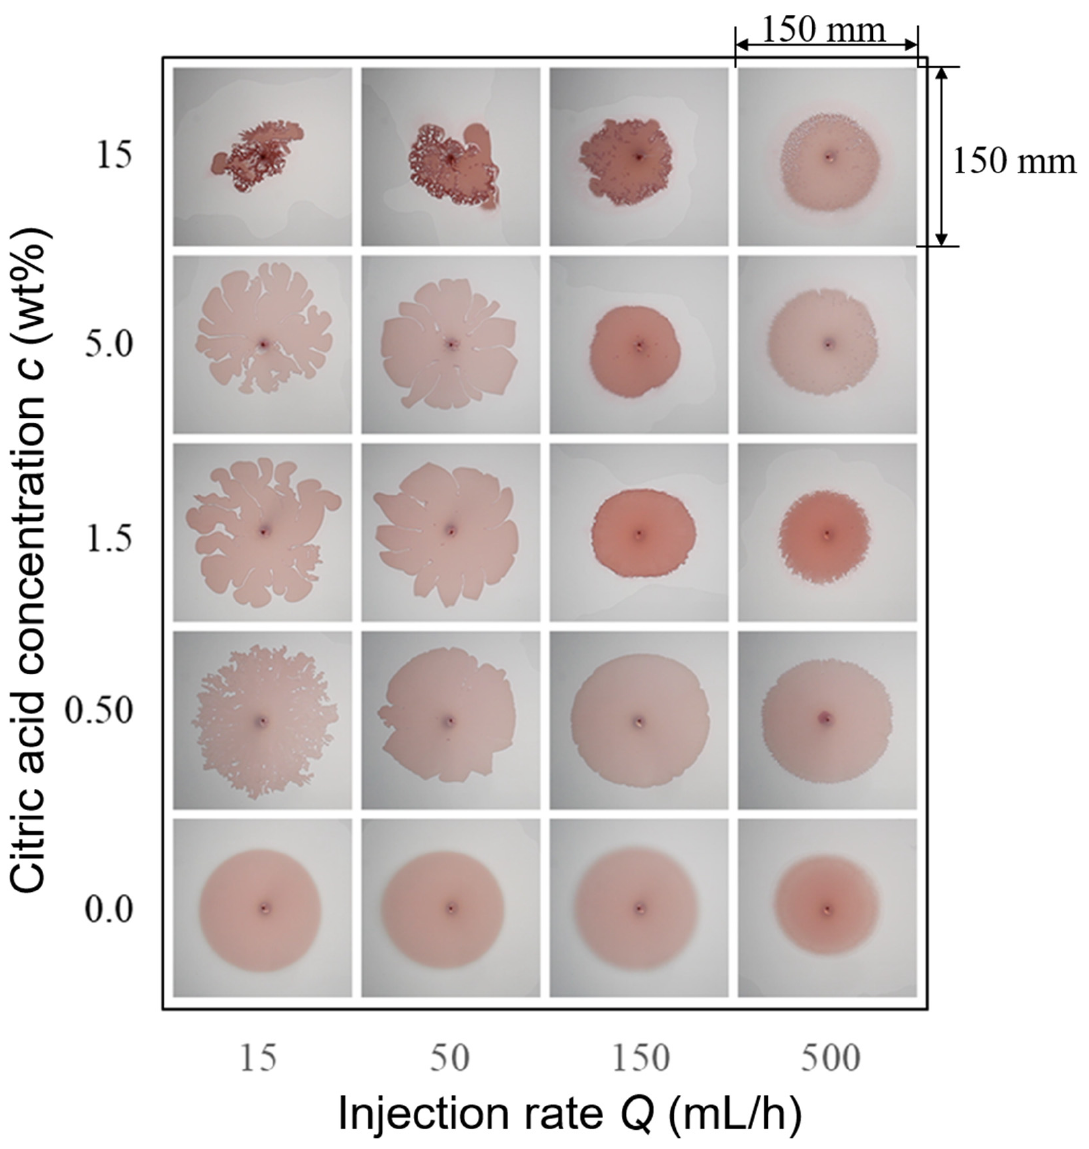
Figure 6. Displacement patterns when skim milk (pink) is injected into citric acid (white) upon injection rates of 15, 50, 150, and 500 mL/h and citric acid concentrations of 0.0 (pure water), 0.50, 1.5, 5.0, and 15 wt%. Images were taken when the injection volume was 2 mL, and the gap width b was 0.4 mm.